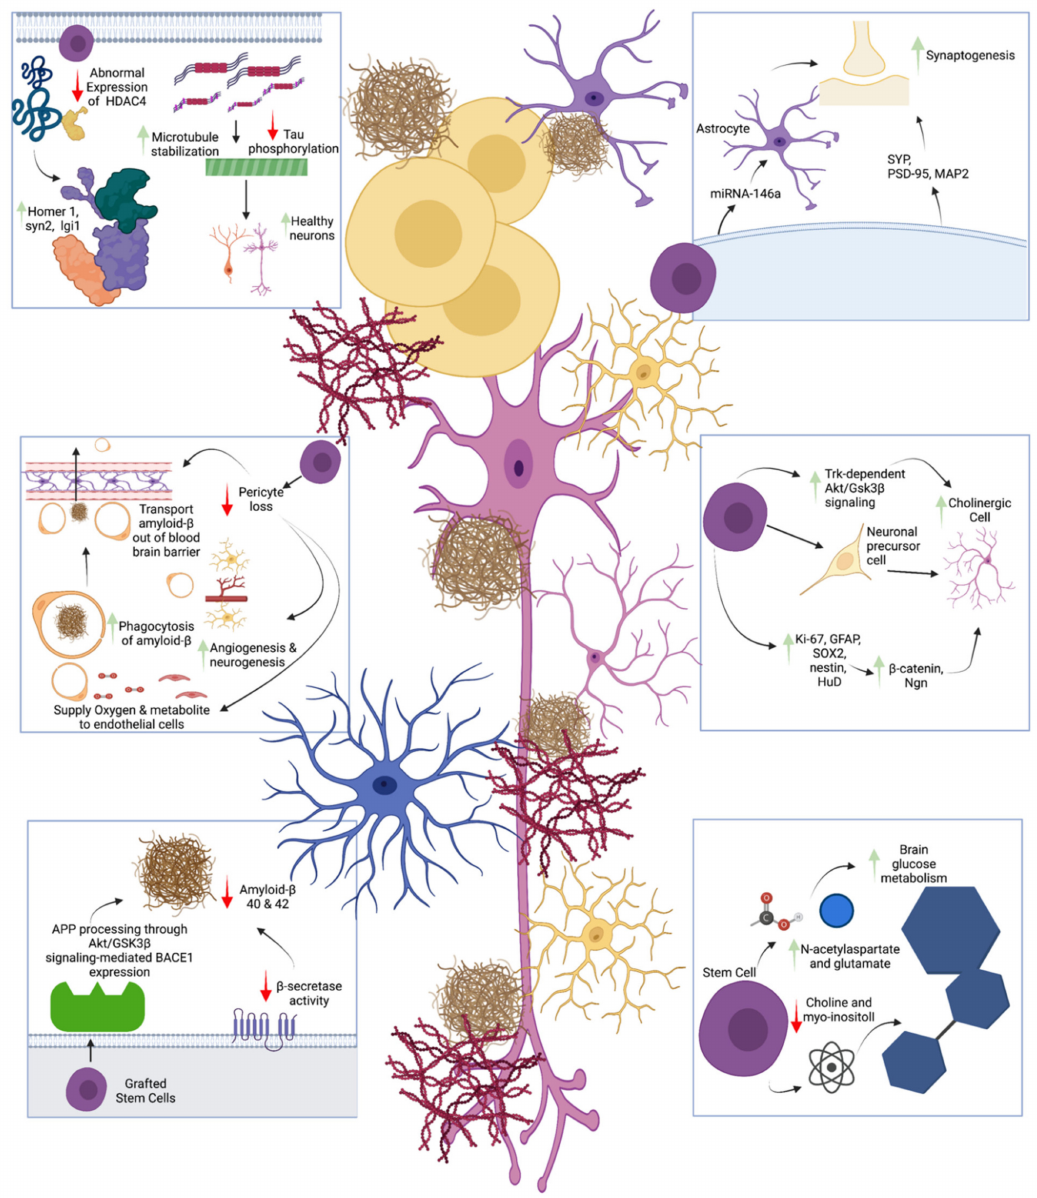
Figure 1. Mechanism of stem cell amelioration of cognition. Stem cells enhance formation of Syp, PSD-95, and MAP2, which can stimulate synaptogenesis. miRNA-146a is also secreted by stem cells and later taken up by astrocytes, leading to synaptogenesis. Stem cells can increase cholinergic neuron production in three ways: 1. increased Trk-dependent Akt/Gsk3 β signaling, 2. differentiation into cholinergic cells, and 3. increased secretion of Ki-67, GFAP, SOX2, nestin, and HuD; increased secretion of β -catenin and neurogenin (Ngn); and increased production of cholinergic cells. Brain glucose metabolism is also increased after stem cell implantation through increased N-acetylaspartate (NAA) and glutamate secretion and decreased choline and myo-inositol secretion. Amyloid- β 40 & 42 are known to cause AD. Stem cells can alter APP processing through Akt/GSK3 β signaling-mediated BACE1 expression and decrease β -secretase activity to decrease amyloid β concentration and improve cognition. Pericytes also have a role in AD. Transplantation of stem cells can inhibit pericyte loss to: 1. promote phagocytosis of amyloid- β , 2. transport amyloid- β across the BBB, 3. supply oxygen and metabolites to endothelial cells, and 4. increase angiogenesis and neurogenesis, which improves cognitive function. Stem cells have a potent effect on tau phosphorylation in AD. They decrease tau phosphorylation, leading to increased microtubule stabilization and healthier neurons, thereby ameliorating cognition